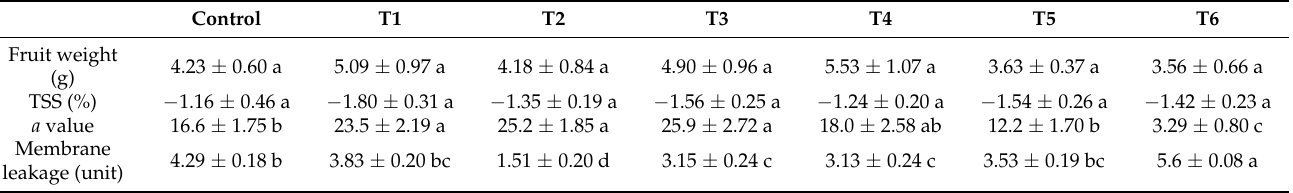
Table 3. Effect on CPPU treatments on increments in fruit weight, TSS, redness value and membrane leakage during 2 weeks from commercial ripeness.